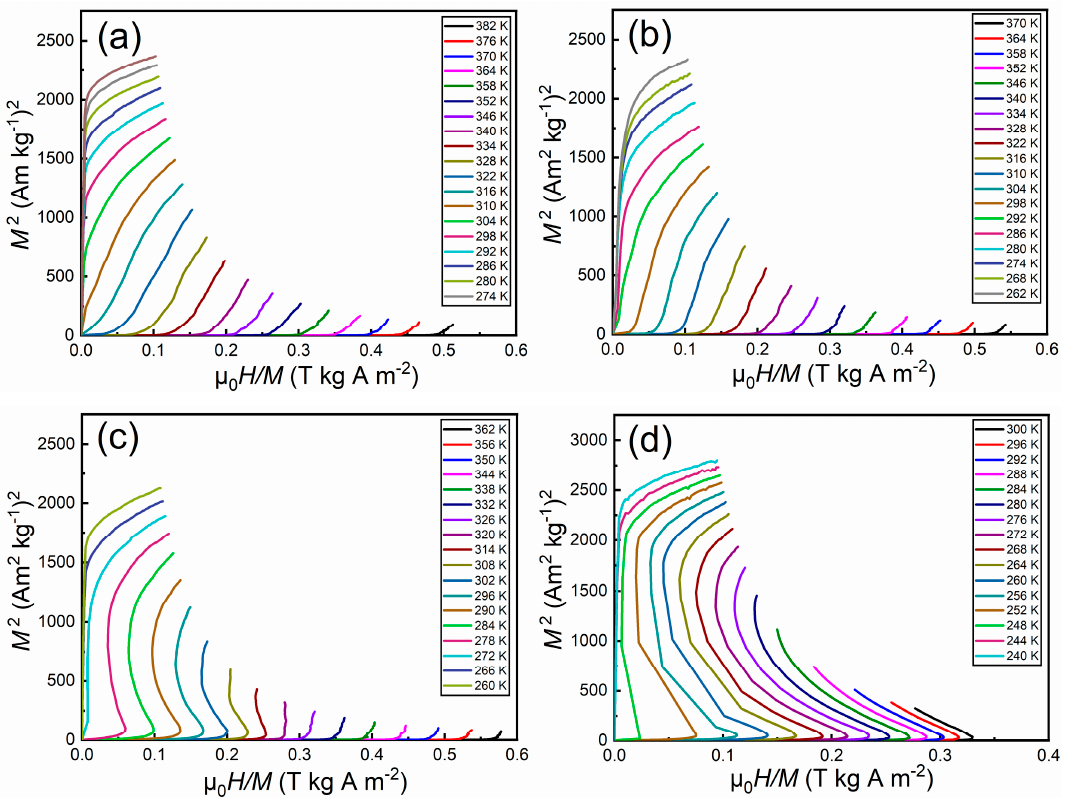
Figure 4. Arrott plots for the Hf 1- x Ta x Fe 2 alloys. ( a ) Hf 0.87 Ta 0.13 Fe 2 ; ( b ) Hf 0.86 Ta 0.14 Fe 2 ; ( c ) Hf 0.85 Ta 0.15 Fe 2 ; ( d ) Hf 0.84 Ta 0.16 Fe 2 .